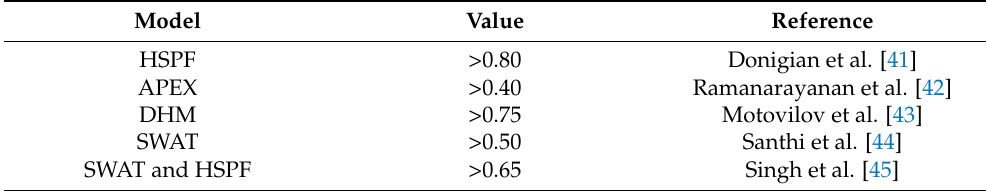
Table 4. Reported NSE values of different hydrological models (adapted by Moriasi et al. [40]).